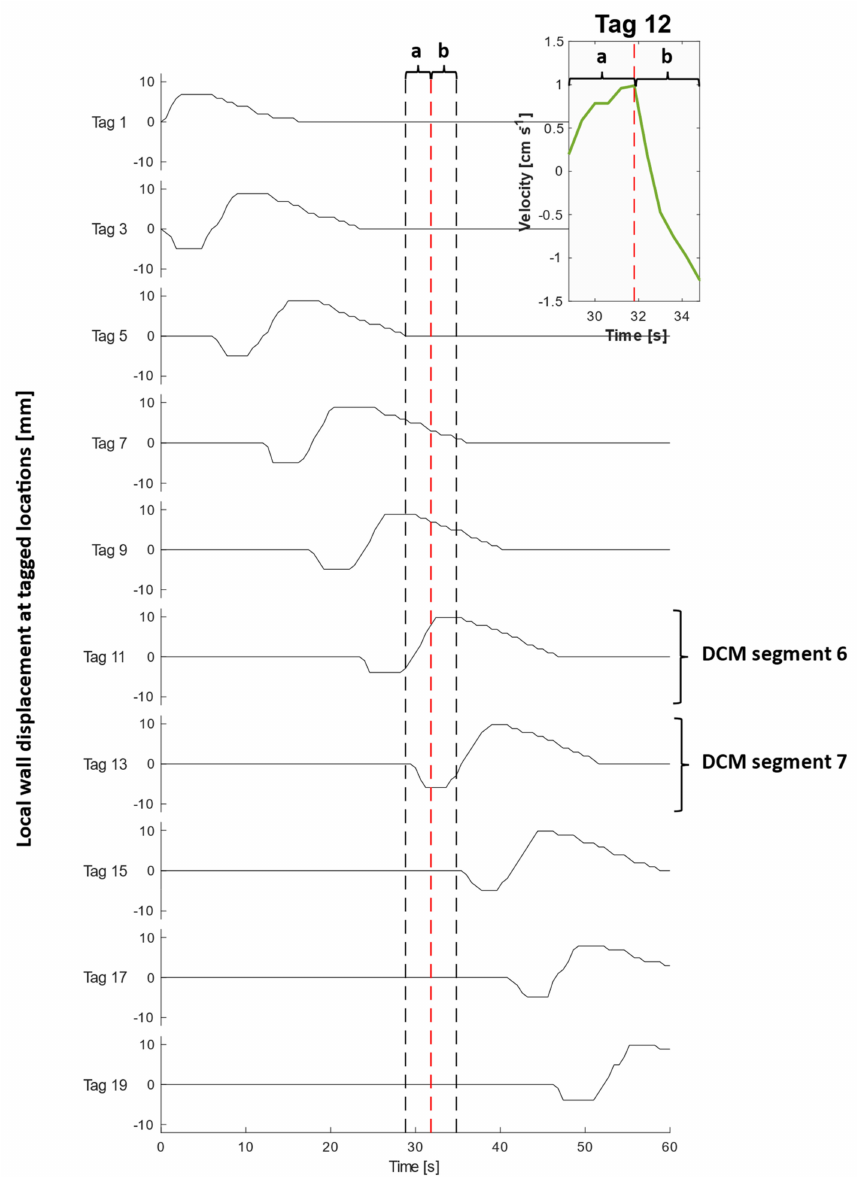
Figure 5. Local wall displacement at each tagged location during a CPPW. Note there is no local wall motion at the location of even-numbered tags due to rigid walls, which have hence been excluded from this plot. The inset graph displays a magnified plot of the velocity of the contents at tag 12 taken from Figure 4, during (a) contraction of segment 6 and relaxation of segment 7 and (b) contraction of segment 7. The black dashed lines bound the timeframe of the inset figure to aid visualisation of local wall motility surrounding tag 12 during the recorded flow